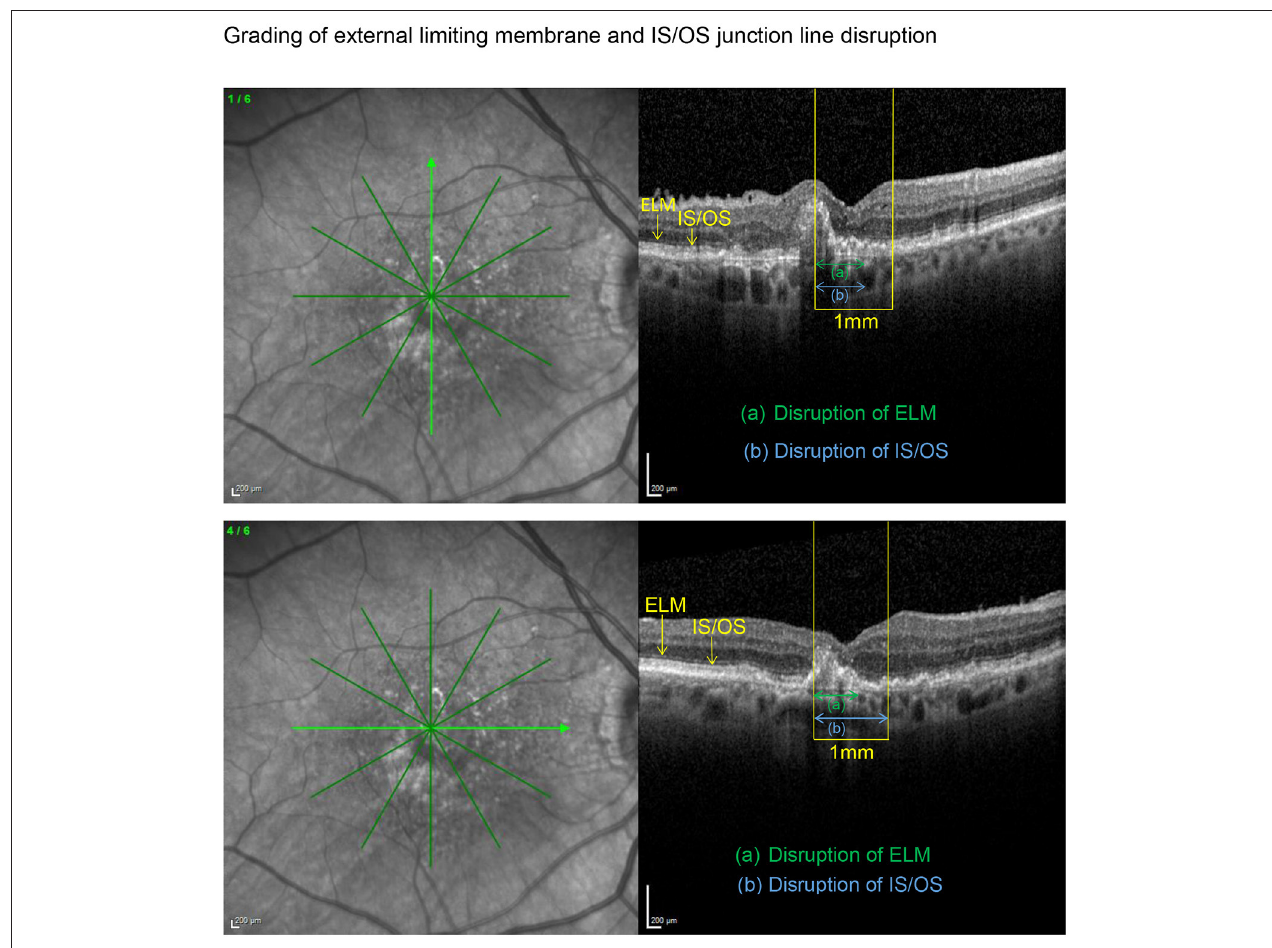
FIGURE 1 | Vertical and horizontal OCT scans in the macular star setting with an ETDRS grid overlay centered on the fovea. After identification of the central 1mm (yellow), the length of the disrupted external limiting membrane (ELM) (green) and IS/OS junction line (blue) were measured with the measuring tool. Grading was carried out as described in the methods section. Subsequently, both disruption scores were calculated as the means of the corresponding scores obtained in the horizontal and vertical scan, respectively. In this example resulted an ELM disruption score of 2 and an IS/OS disruption score of 2.5 with an impaired BCVA of 58